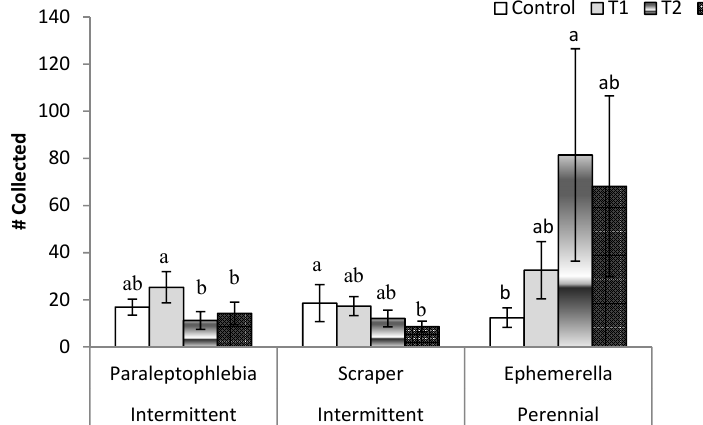
Figure 2. Pre-harvest differences in Paraleptophlebia and total Scraper abundance (intermittent stream segments) and Ephemerella (perennial stream segments) across streamside management zone (SMZ) treatments at Robinson Forest, Kentucky (USA). Columns within each response variable which share letters are not significantly different from one another ( p < 0.05). Table 2. Pre-harvest effects * of SMZ treatment, season, and their interaction on benthic macroinvertebrate abundance at Robinson Forest, Kentucky (USA).